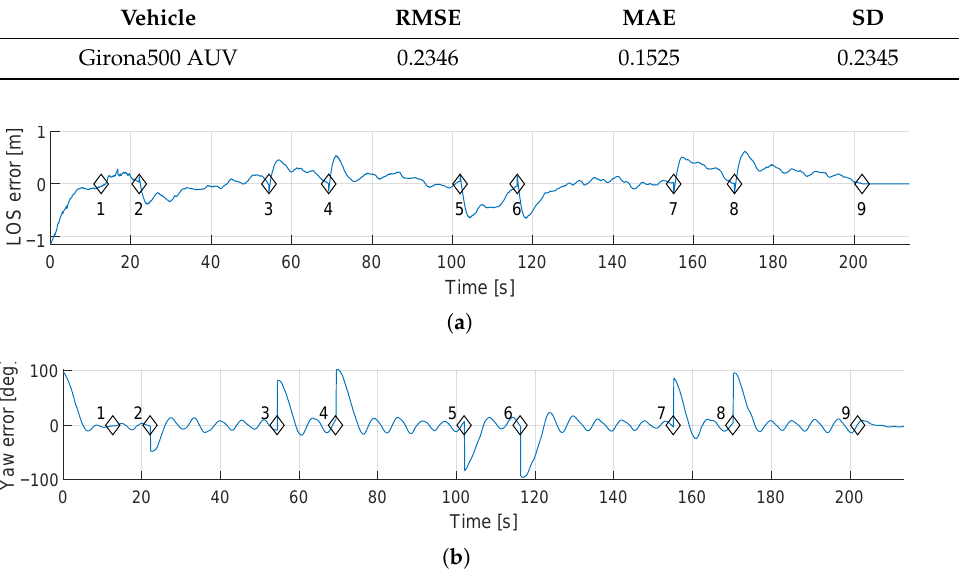
Figure 15. AUV tracking trajectory for the sea trials in NED coordinate system: ( a ) North, East, and Down, ( b ) Yaw. Table 4. Comparison of non-dimensional indicators for the AUV tracking trajectory.